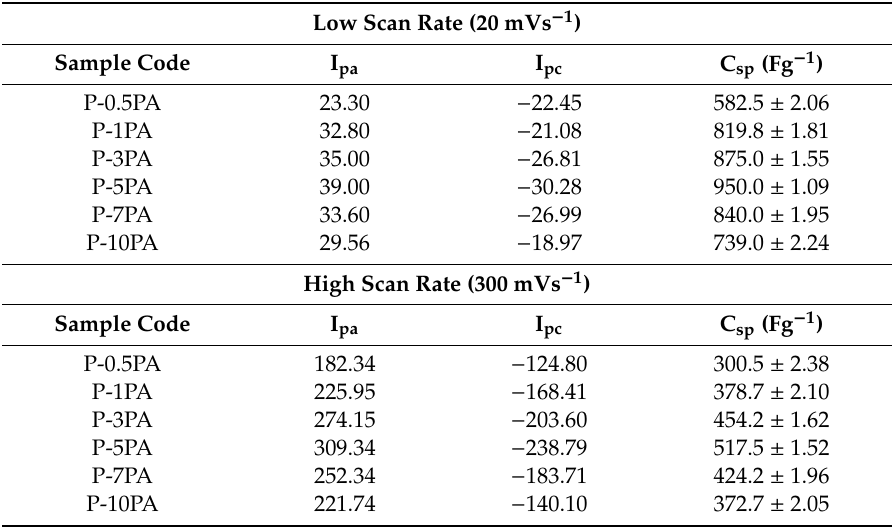
Figure 4. Cyclic voltammetry (CV) curves of various PANI salts in 1 M H 2 SO 4 solution ( a ) at scan rate of 20 mVs − 1 ; ( b ) histogram showing C sp values calculated from CV curves at scan rate of 20 mVs − 1 ; ( c ) at scan rate of 300 mVs − 1 ; ( d ) histogram showing C sp values calculated from CV curves at scan rate of 300 mVs − 1 . Table 3. Anodic peak current (I pa ), cathodic peak current (I pc ) and specific capacitance (C sp ) with standard error of various PANI samples at low (20 mVs − 1 ) and high (300 mVs − 1 ) scan